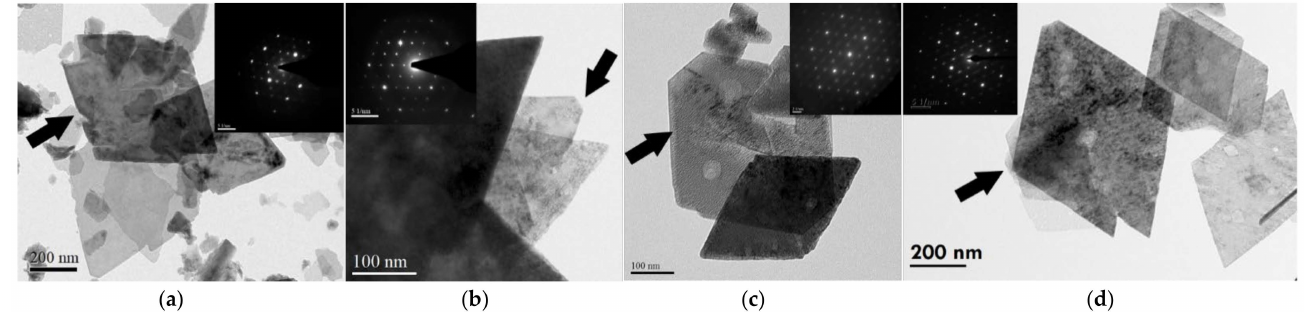
Figure 4. TEM micrographs and diffraction patterns of thermally treated boehmite, ( a ) boehmite parti- cles, ( b ) meta- γ particles, ( c ) γ -Al 2 O 3 particles pseudomorph after boehmite, and ( d ) γ -Al 2 O 3